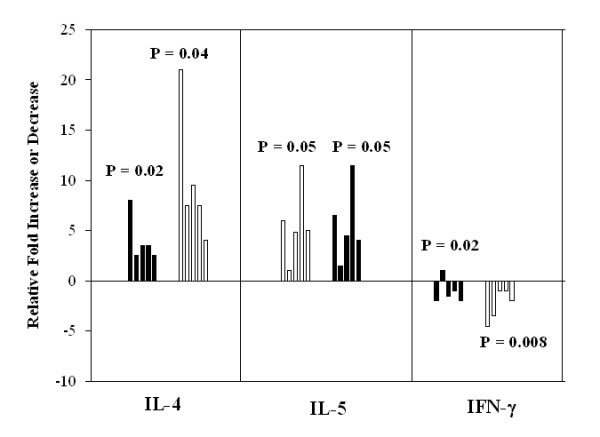
ATRA and 9-cis-RA upregulate the expression of IL-4 and IL-5 mRNA and down-regulates the expression of IFN-(within anti-CD3 mAb-stimulated PBMC. Taqman® semi-quantitative PCR for IL-4, IL-5 and IFN-(transcripts was performed using total cellular RNA of 48 h, anti-CD3 mAb-activated PBMC (2.5 × 106/ml) treated with ETOH or 10-7 M of ATRA (□) or 9-cis-RA (■). The media used in this experimental series also contained a low dose of rhIL-2 (10 U/ml). Values obtained for each cytokine message was normalized to that obtained for 18S rRNA in the same sample as described in the Methods. The normalized values were then expressed as a function of the ETOH control sample. The relative copy number of PBMC IL-4 and IL-5 was increased by ATRA and 9-cis-RA in all donors tested, while the relative copy number of IFN-(mRNA were decreased by ATRA. The results are expressed as relative fold increase or decrease in mRNA expression. A paired T test was performed on the values derived from five donors as described in the Methods and the P values from the pooled donor data comparisons are listed for each cytokine and RA stimulation.